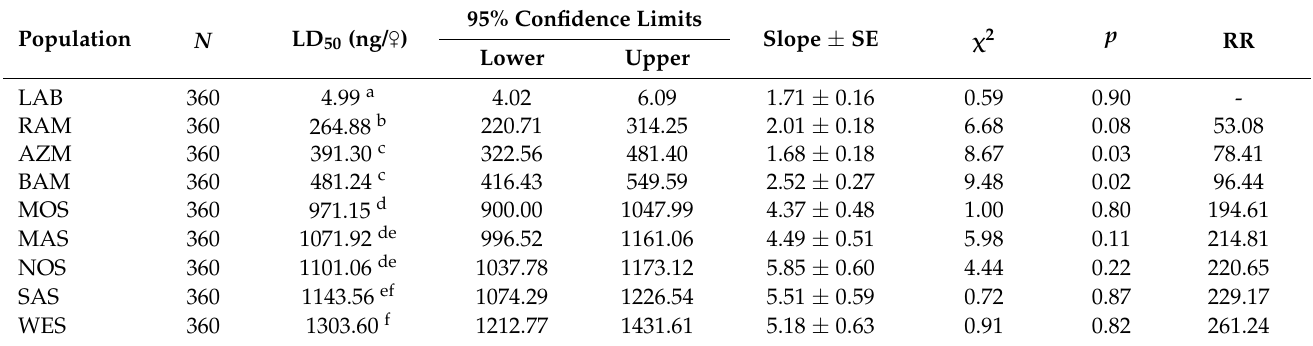
Median lethal doses (LD 50 ) and resistance ratio (RR) of Musca domestica treated with fenitrothion.